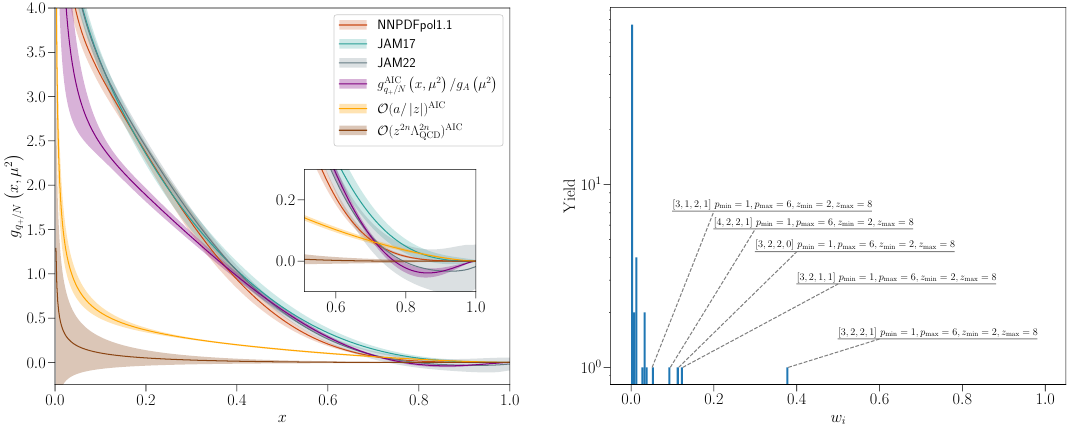
(cid:0) (cid:1) ν, z 2 cut on p latt ∈ [1 , 6] and (cid:0) (cid:1) z 2 n Λ 2 n higher-twist (brown) QCD